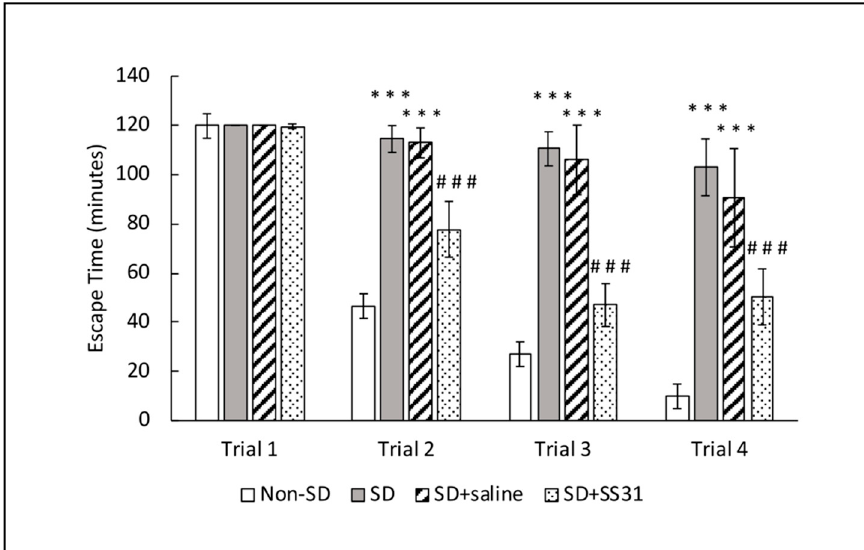
Figure 1. Learning impairment in aging mice induced by sleep deprivation was prevented with SS31. Mice were given four trials to escape the box maze for a maximum of 2 min each, and their escape times were recorded. The data represent the mean ± SEM ( n = 10 per group). *** p < 0.001, statistically significant difference between SD group/SD+Saline group and Non-SD group. ### p < 0.001, statistically significant difference between SD+SS31 group and SD group/SD+Saline group.